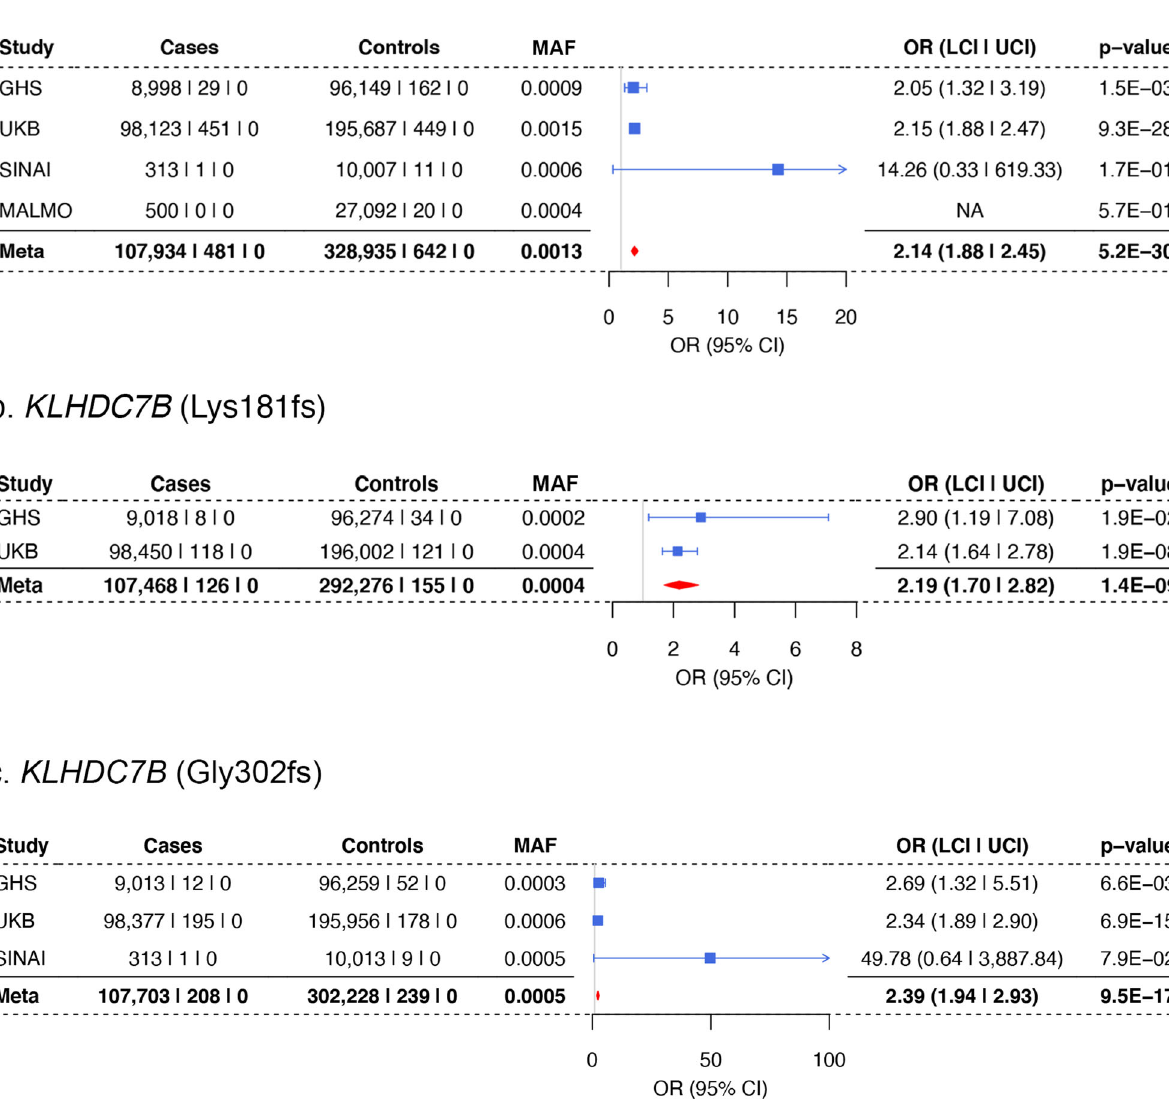
Fig. 3 Association of rare variants in KLHDC7B with increased risk for hearing loss in meta-analysis. a Association of an aggregate of predicted loss-of- function variants (MAF ≤ 0.01) in KLHDC7B with risk for hearing loss. b , c . Two variants were the predominant contributors to the KLHDC7B loss-of- function gene burden aggregate, Lys181fs ( b ) and Gly302fs ( c